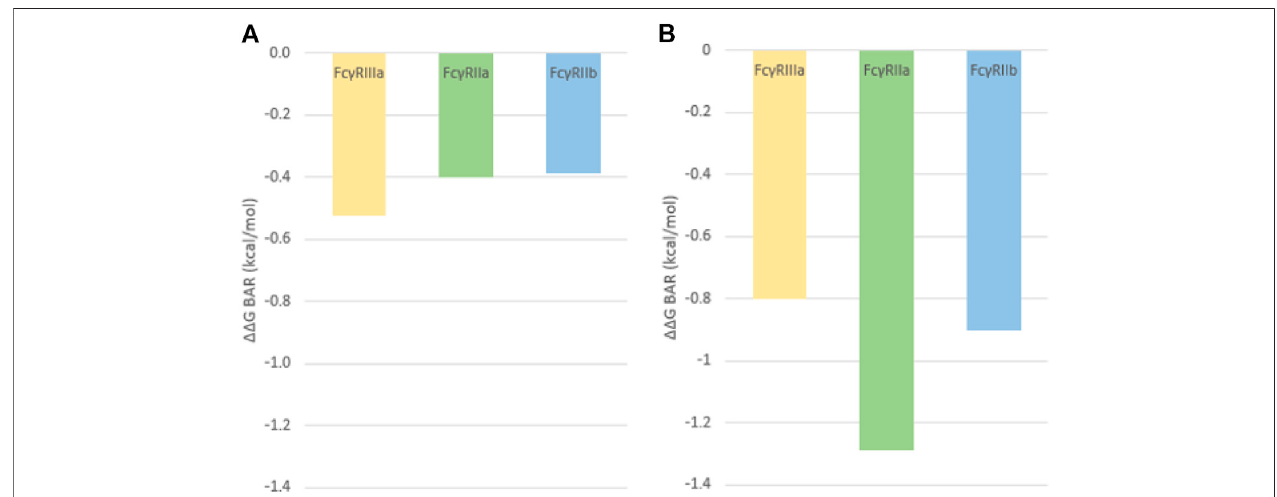
FIGURE 6 | Relative binding free energies calculated using the BAR method and representing the relative change in binding free energy after the induction of the G236A substitution for (A) the complete antibody simulation and (B) the isolated Fc region simulation.